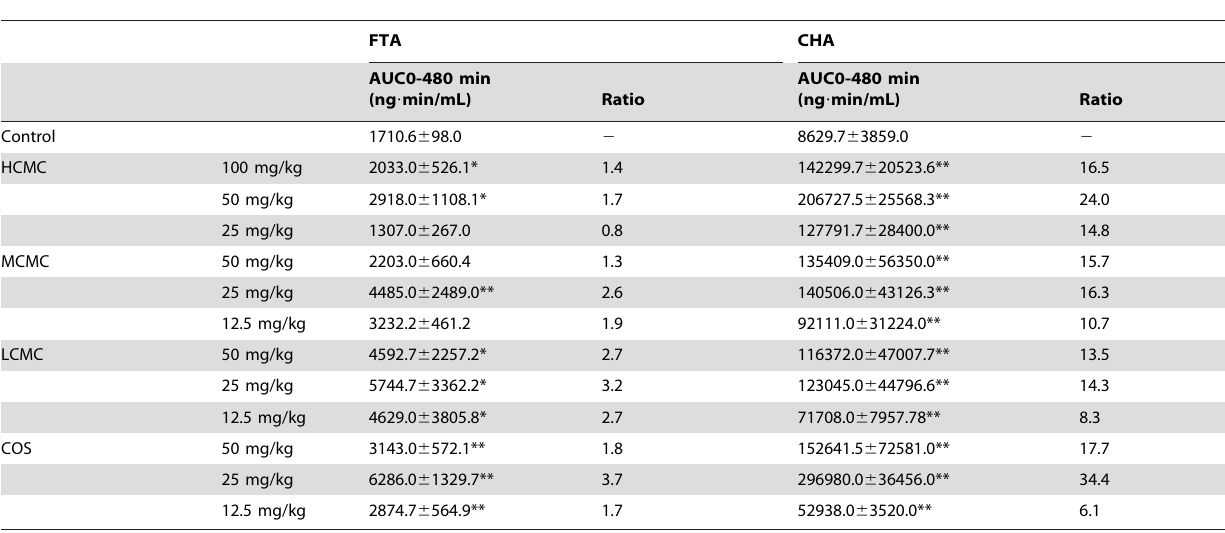
Table 4. Effects of chitosan derivatives on the absorption of FTA and CHA by in vivo pharmacokinetics study.